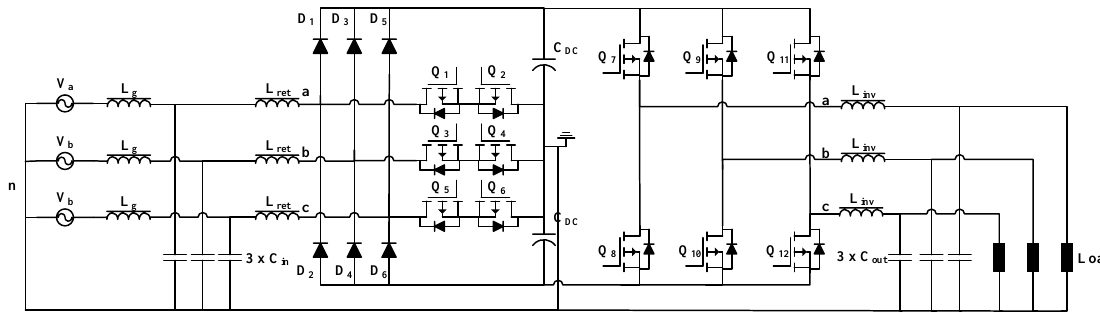
Figure 1. Proposed AC-DC-AC